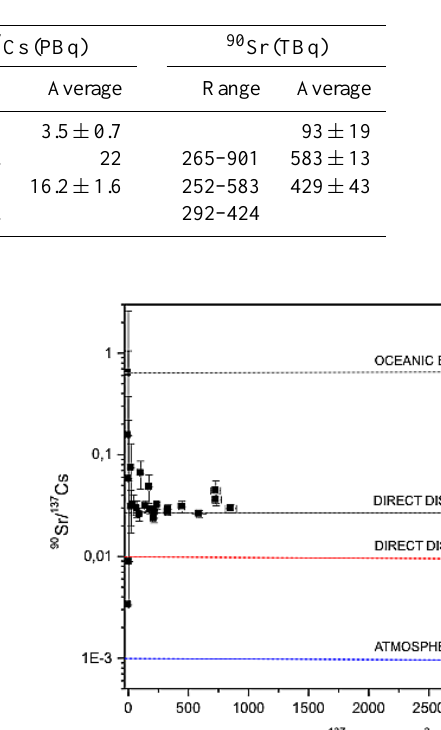
Table 3. Amounts of 90 Sr released into the sea from the Fukushima NPP by June 2011, in TBq( × 10 12 Bq), calculated using the published estimates of 137 Cs releases and a 90 Sr/, 137 Cs ratio of 0.0265 ± 0.0006. The leakage 90 Sr occurred in December 2011 is not included in these estimates.